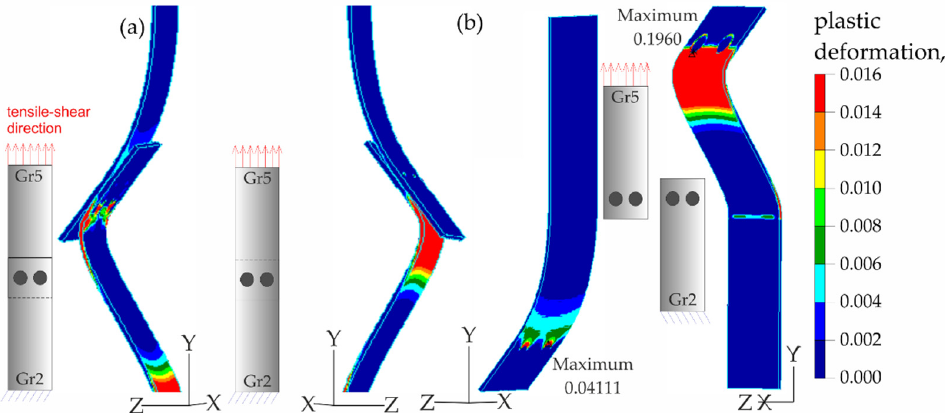
Figure 18. Distribution of plastic deformations in the Gr2–Gr5-3 joints: ( a ) on the surface of the entire joint and ( b ) on the inner surfaces of the joints.